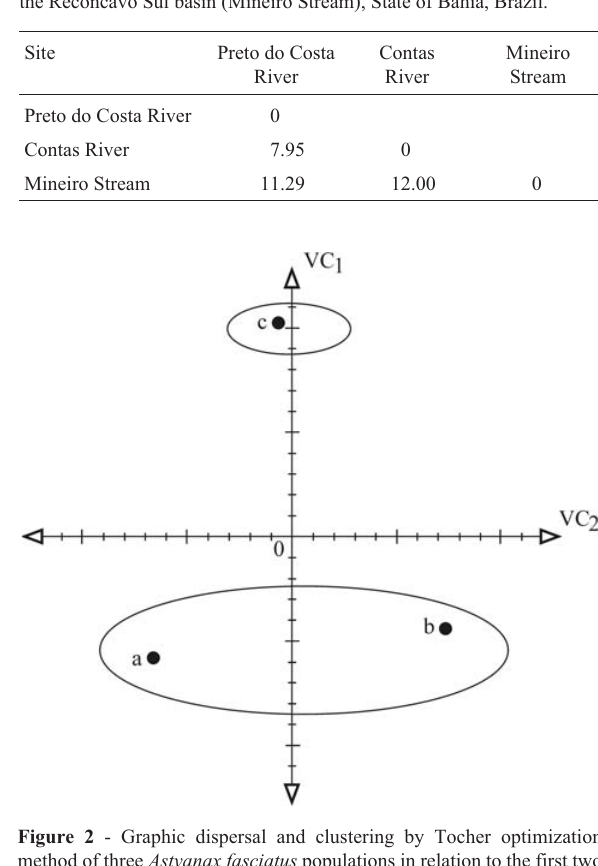
Table 3 - Mean interpopulation distances (Mahalanobis distance esti- mates based on morphometric data) of Astyanax fasciatus in two sites of the Contas River basin (Contas and Preto do Costa Rivers) and one site of the Recôncavo Sul basin (Mineiro Stream), State of Bahia, Brazil.